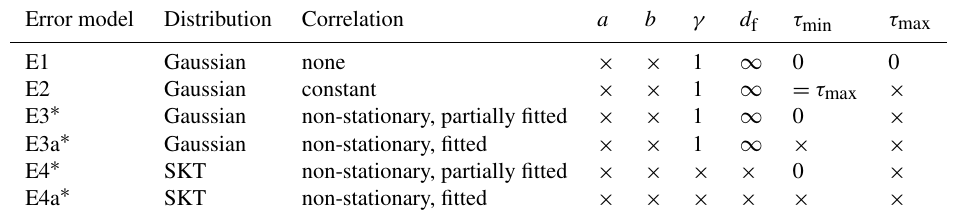
Table 1. Overview of the error models applied in this study, their assumptions regarding correlation and the distribution of streamflow and their corresponding parameters (SKT: skewed Student’s t distribution, × : fitted).